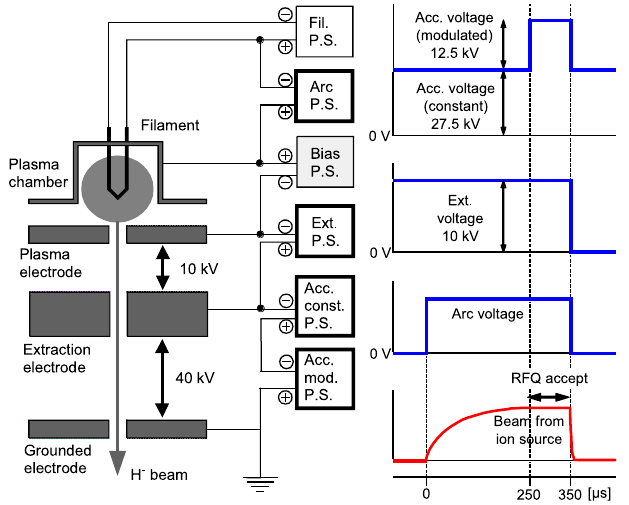
FIG. 8. (Color) Typical schematic drawing of time sequence of ion source power